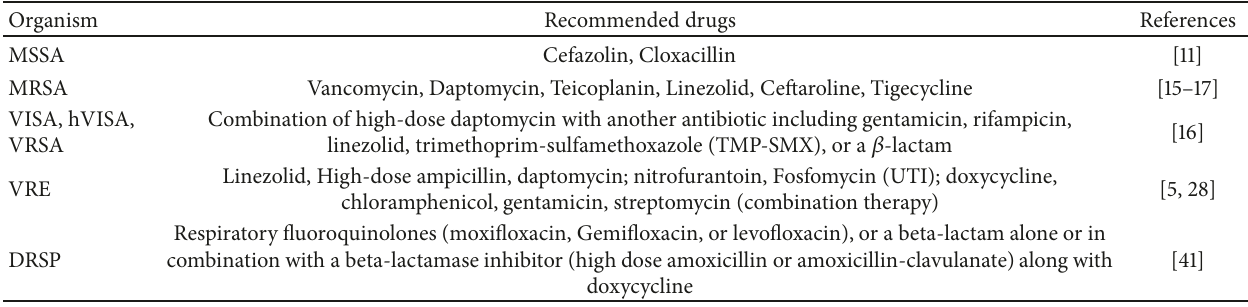
Table 1: Gram positive organisms and recommended antimicrobial agents.